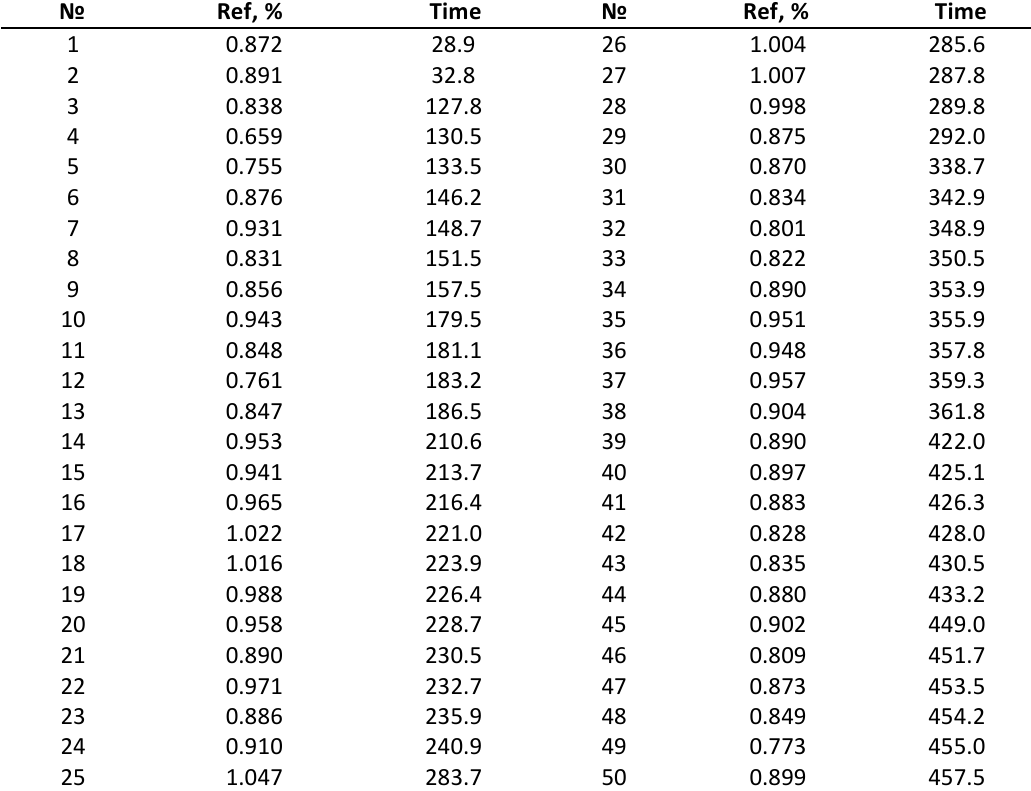
Table 3. The measured results of %R